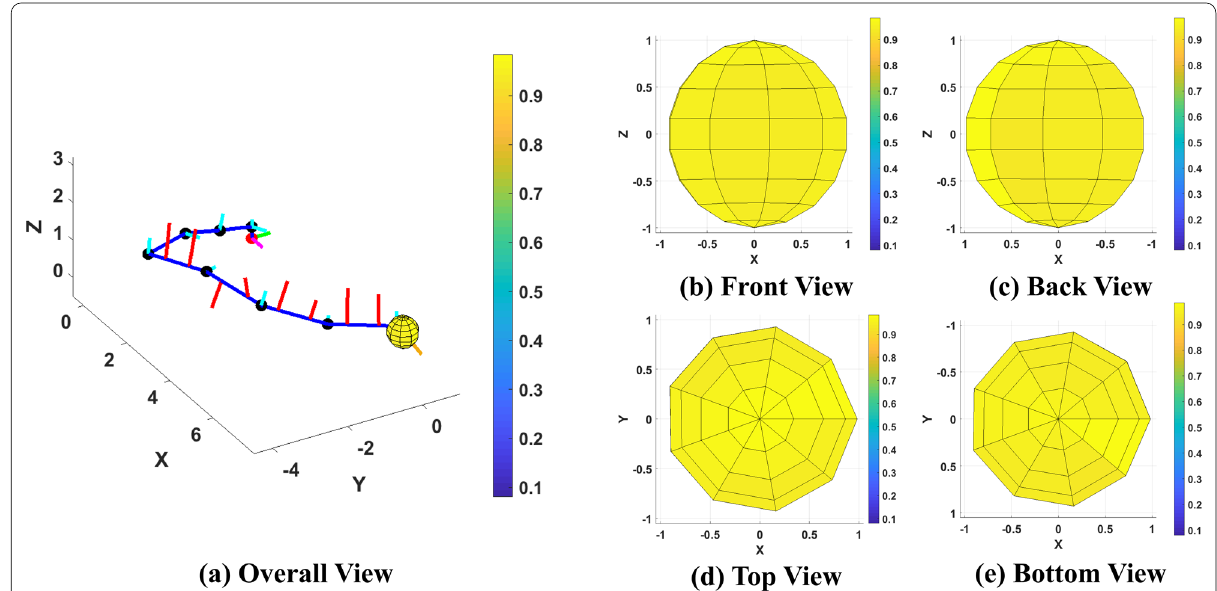
Fig. 13 a Overall view of the AOWS-based flying watch allocation, end effector reaction force, and the corresponding average TDS in the object